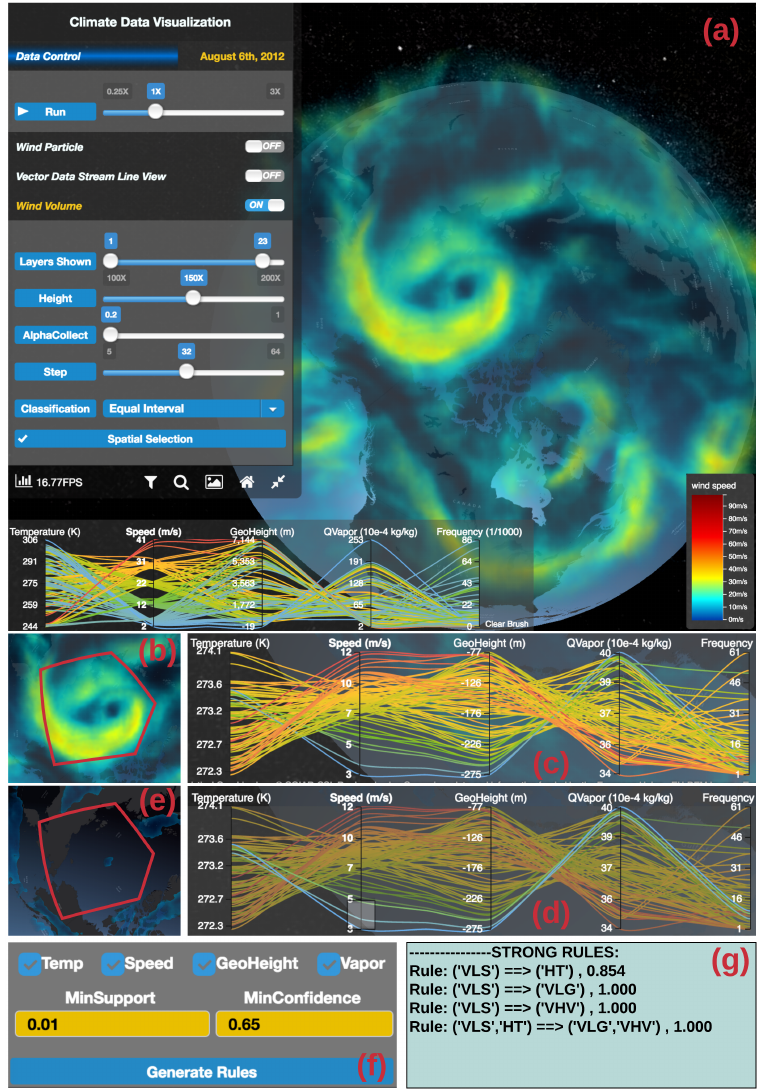
Figure 6. A user case study of climate dataset exploration in our system. The cyclone tracked is “The Great Arctic Cyclone of 2012" on 6 August 2012.